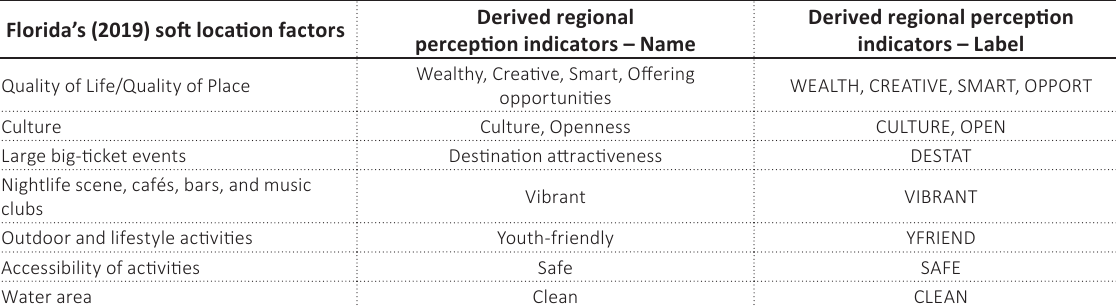
Table 1. Regional perception